Question: Describe this figure in one sentence.
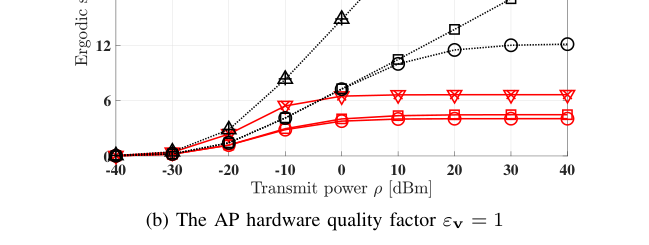
Answer: Theoretical (31), (37) and simulation comparison of the ergodic sum-rate versus the transmit power in various combining methods.